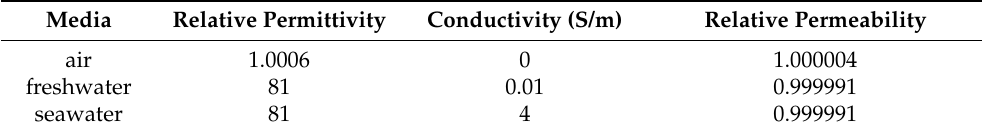
Table 1. Parameters Compassion of Three